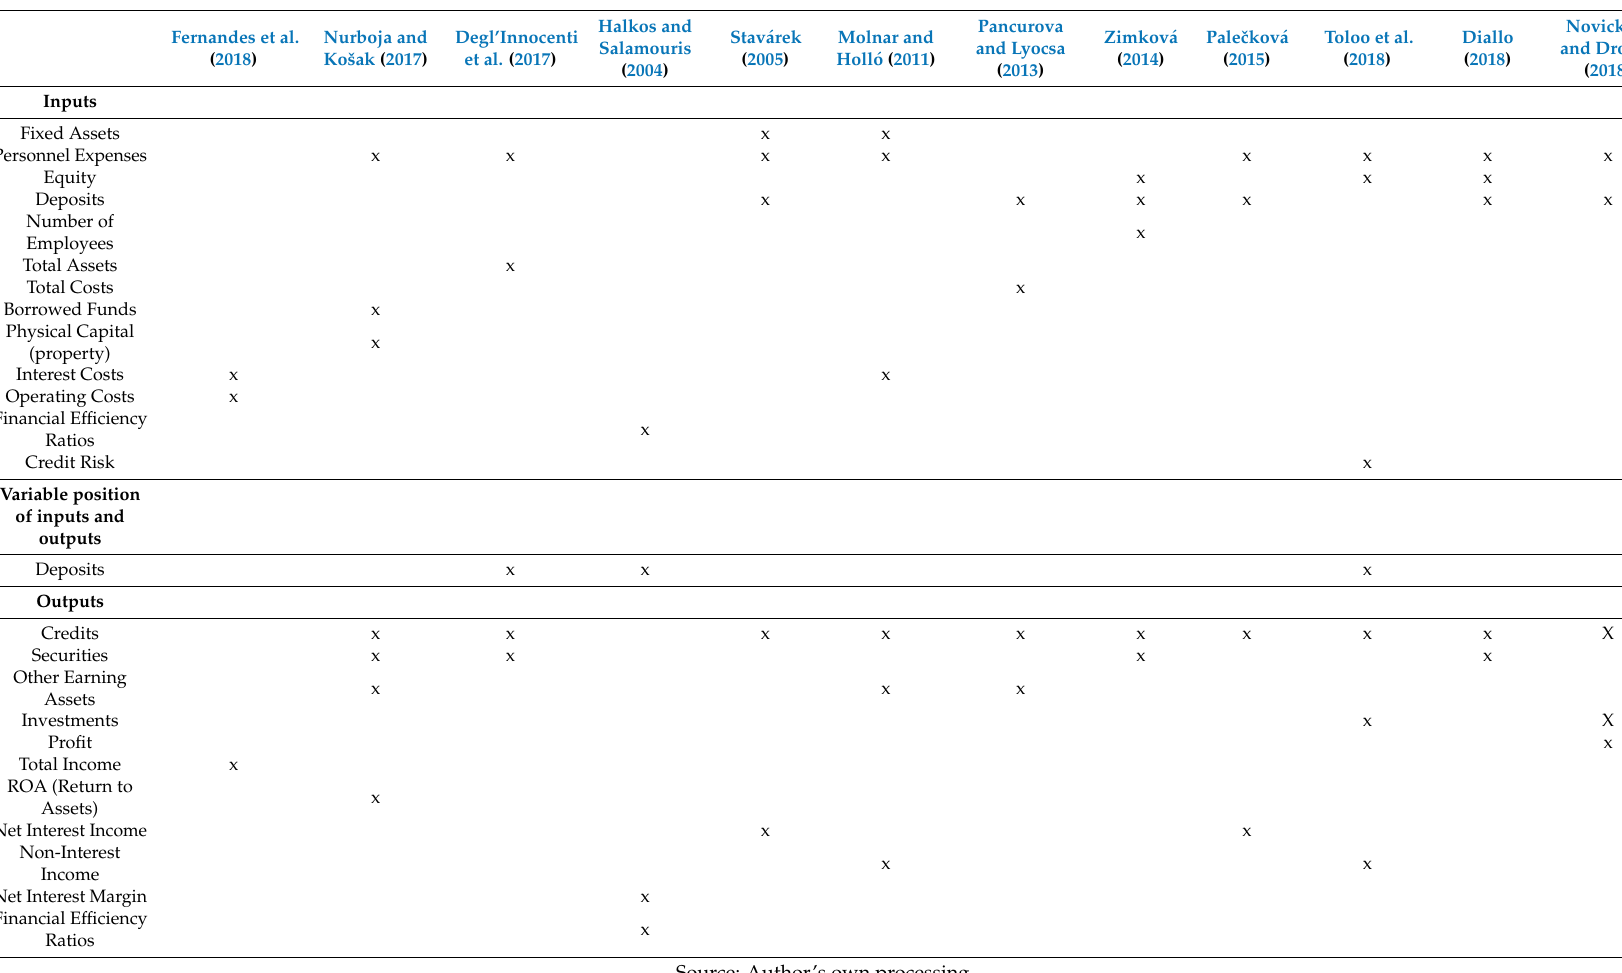
Table 4. Comparison of input and output combinations in selected